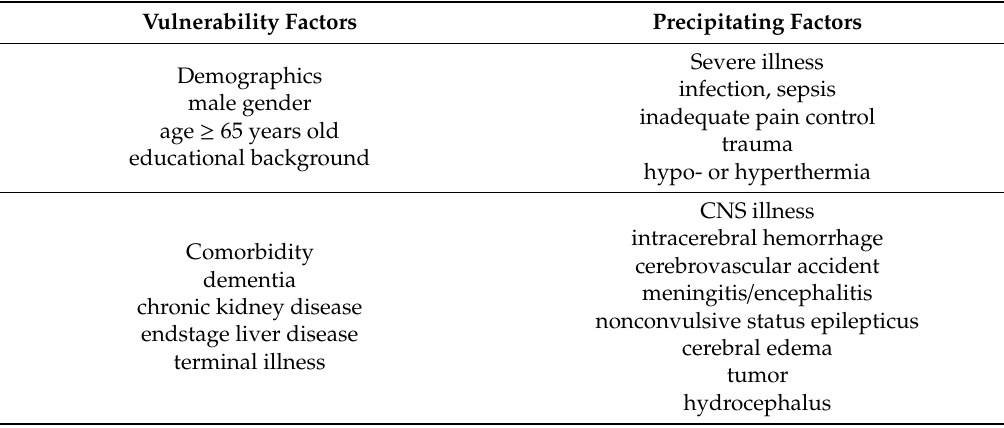
Table 1. Vulnerability and precipitating factors for delirium